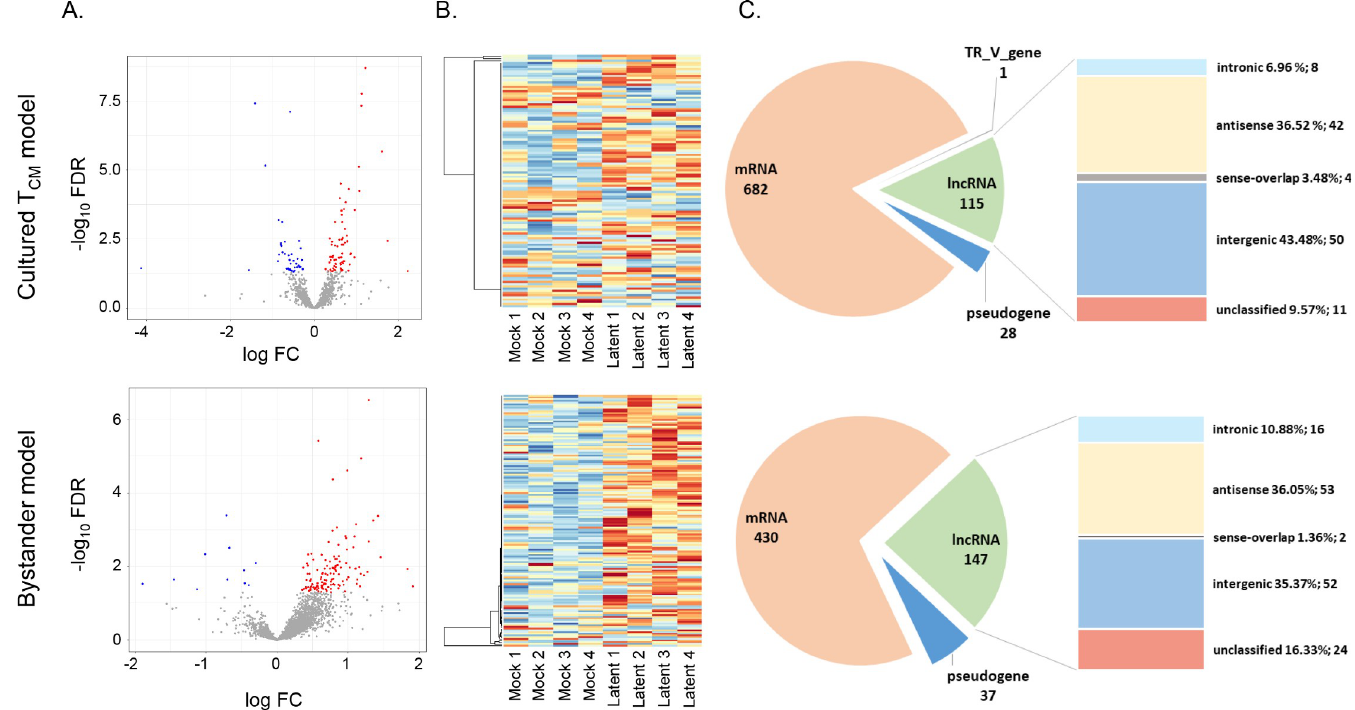
Fig 2. Overview of differentially expressed lncRNAs in the cultured T CM and the bystander models of HIV latency. (A) Volcano plots showing all lncRNAs (grey dots). Significantly up-regulated lncRNAs (red dots) and down-regulated lncRNAs (blue dots) are highlighted for both latency models. (B) Heatmaps of differentially expressed lncRNAs. (C) Number of differentially expressed mRNAs, pseudogenes, TR_V genes, and lncRNAs, and percentages of lncRNAs of different types out of the total dysregulated lncRNAs.